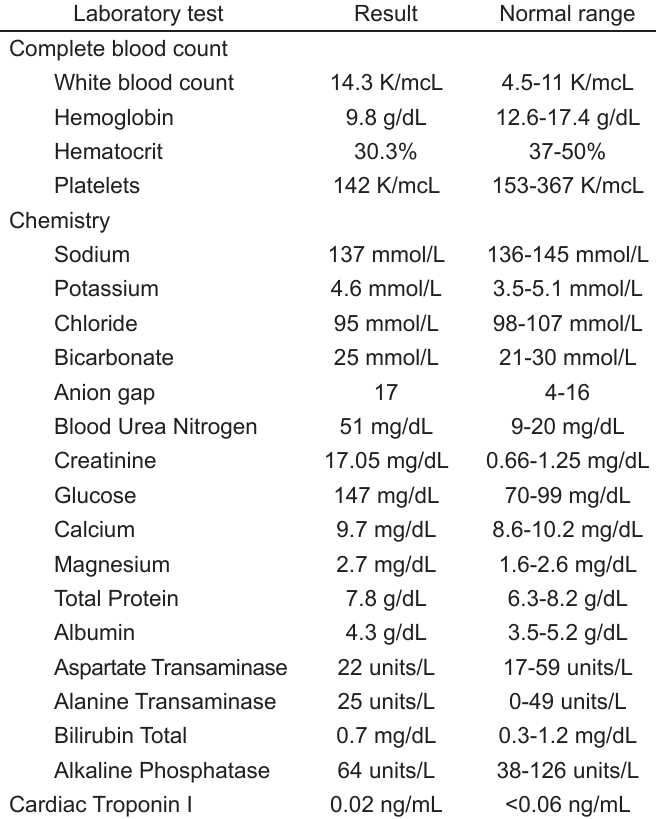
Table. Laboratory test results of a 55-year-old male on hemodialysis who presented to the emergency department with fatigue.